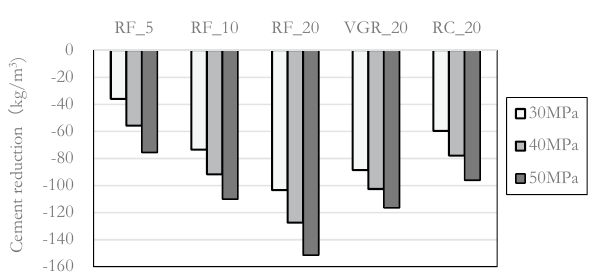
Fig. 23 Unit cement reduction to achieve compressive strengths of 30, 40 and 50